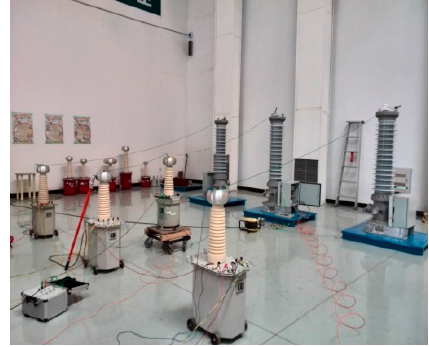
Figure 4. The adjacent phase effect test in the laboratory.